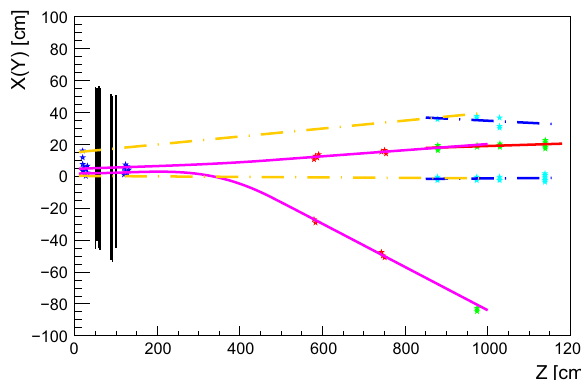
Fig. 2 A two-muon event (most events are single-muon events) in the event display. The blue crosses are hits in Drift-tube stations T1 and T2, the red crosses are hits in T3 and T4. The green and light blue are hits in the RPC stations. The orange (blue) dotted lines are drift tube (RPC) track segments in the y projection; the pink (red) curves are track segments in the x projection